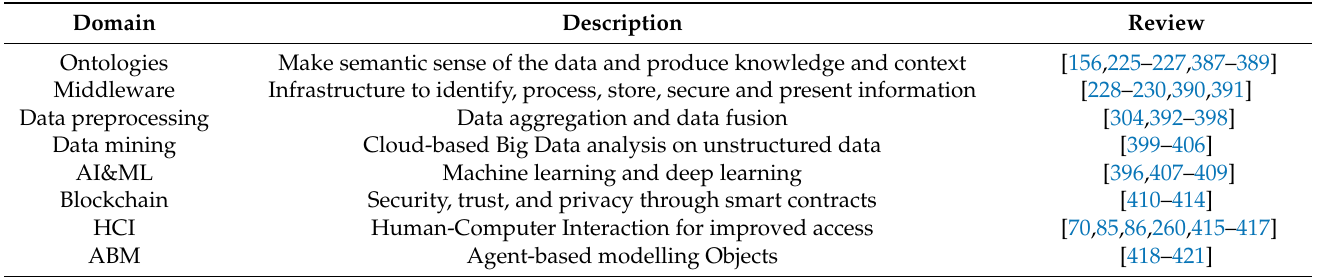
Table 5. Research Areas for Digital Twin Analytics.